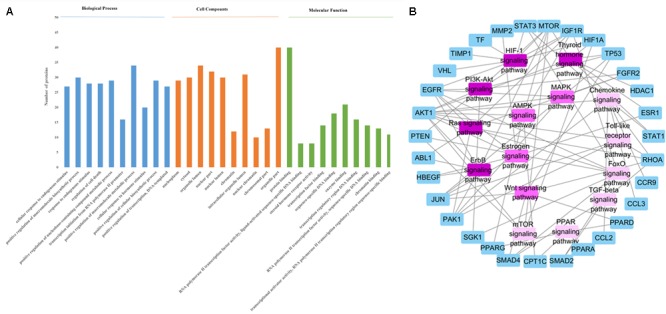
(A) The enrichment analysis in biological processes, cellular components and molecular functions of 79 identified target proteins by STRING database. (B) The Target protein-Pathway network. Blue nodes refer to target proteins. The pink nodes represent pathways, and the color is consistent with pathways related target protein numbers, the deeper the pink, the more number of proteins.